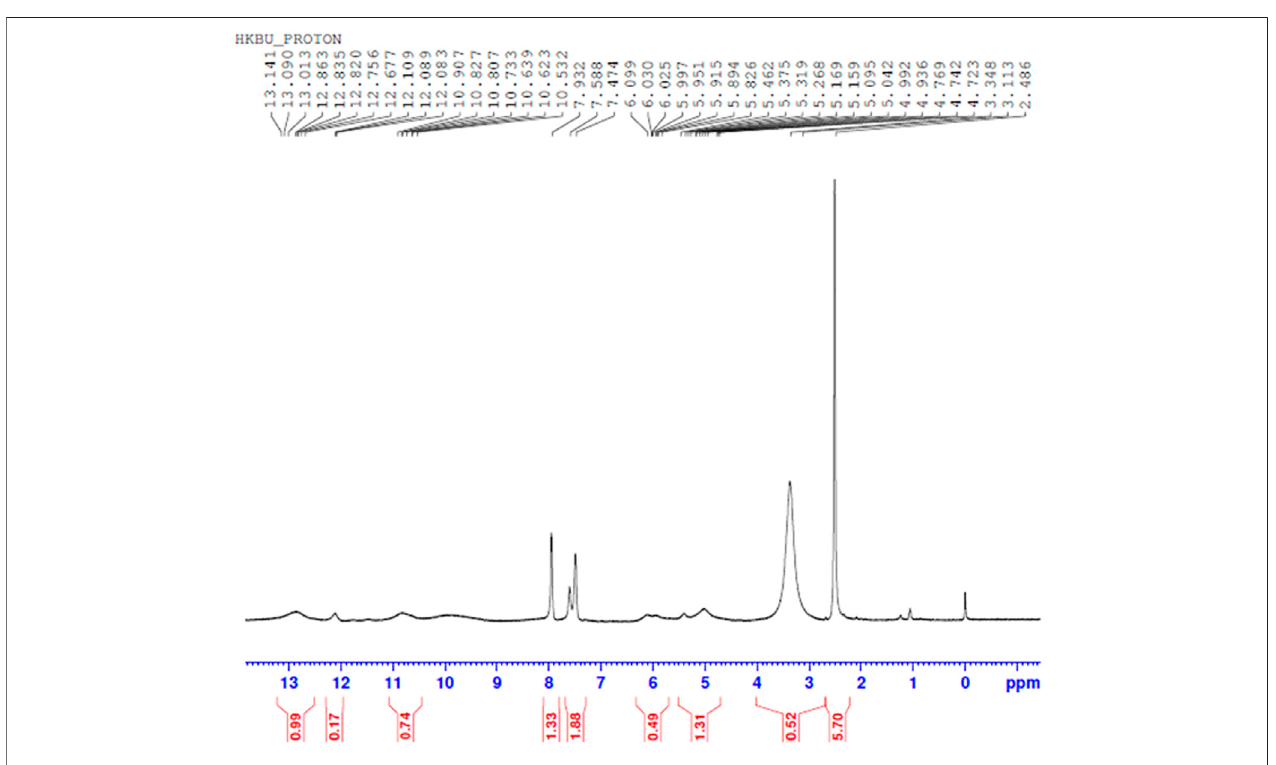
FIGURE 13 | 1 H NMR spectrum resulting from the addition of benzoic acid to iron sulfate and chromium sulfate mixed solution at 80 ° C to obtain precipitated product.